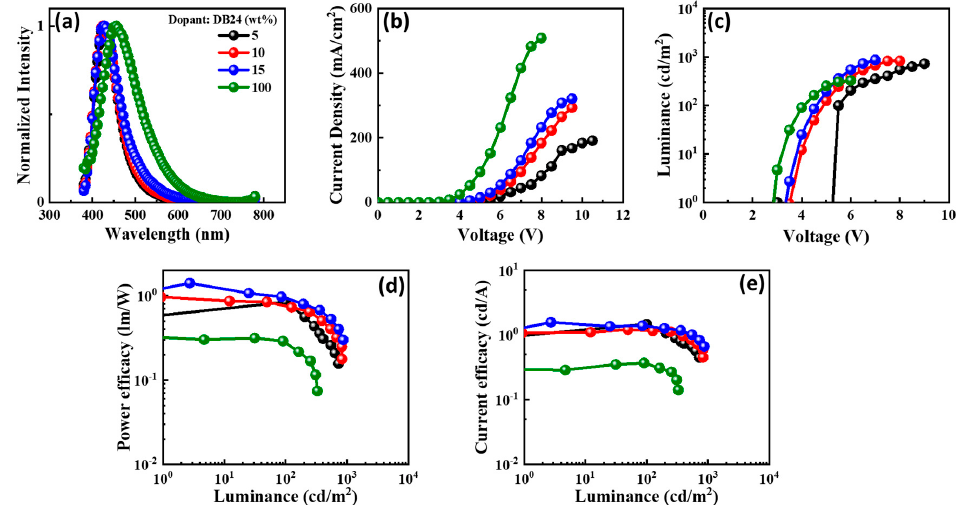
Figure 13. The electroluminescent (EL) properties of the device with emitter DB24 doped in CBP host matrix at varying concentrations showing ( a ) EL spectra, ( b ) current density–voltage, ( c ) luminance–voltage, ( d ) power e ffi cacy–luminance, and ( e ) current e ffi cacy–luminance characteristics.